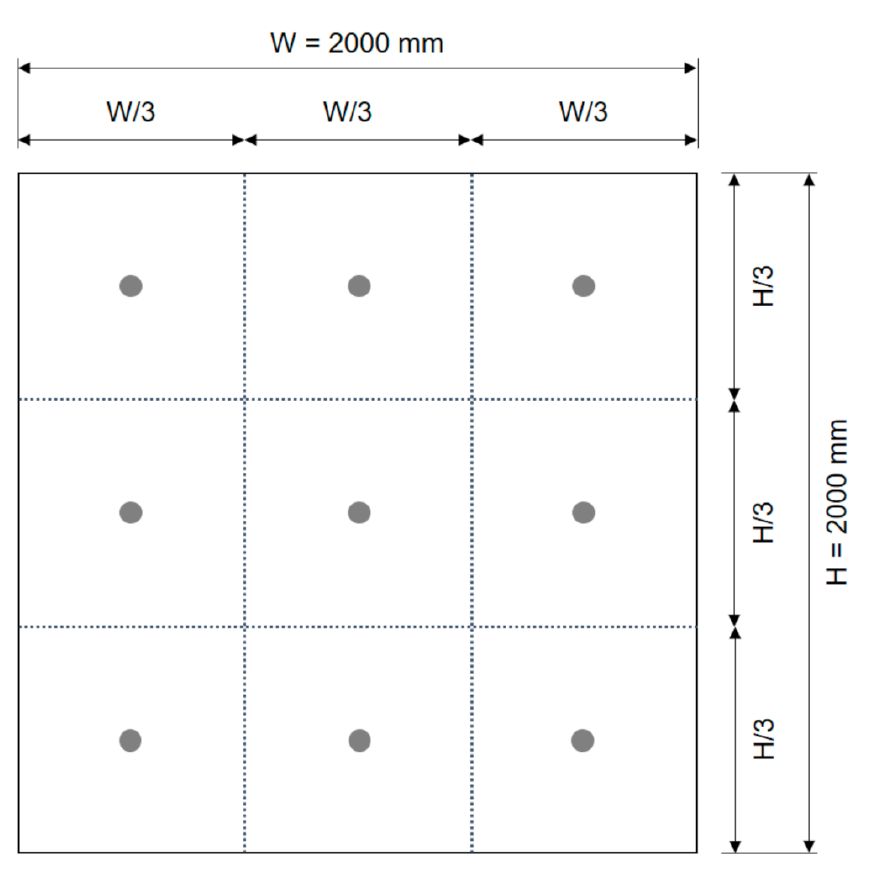
Figure 13. Installation of mock-up: ( a ) cold box side; ( b ) hot box side.